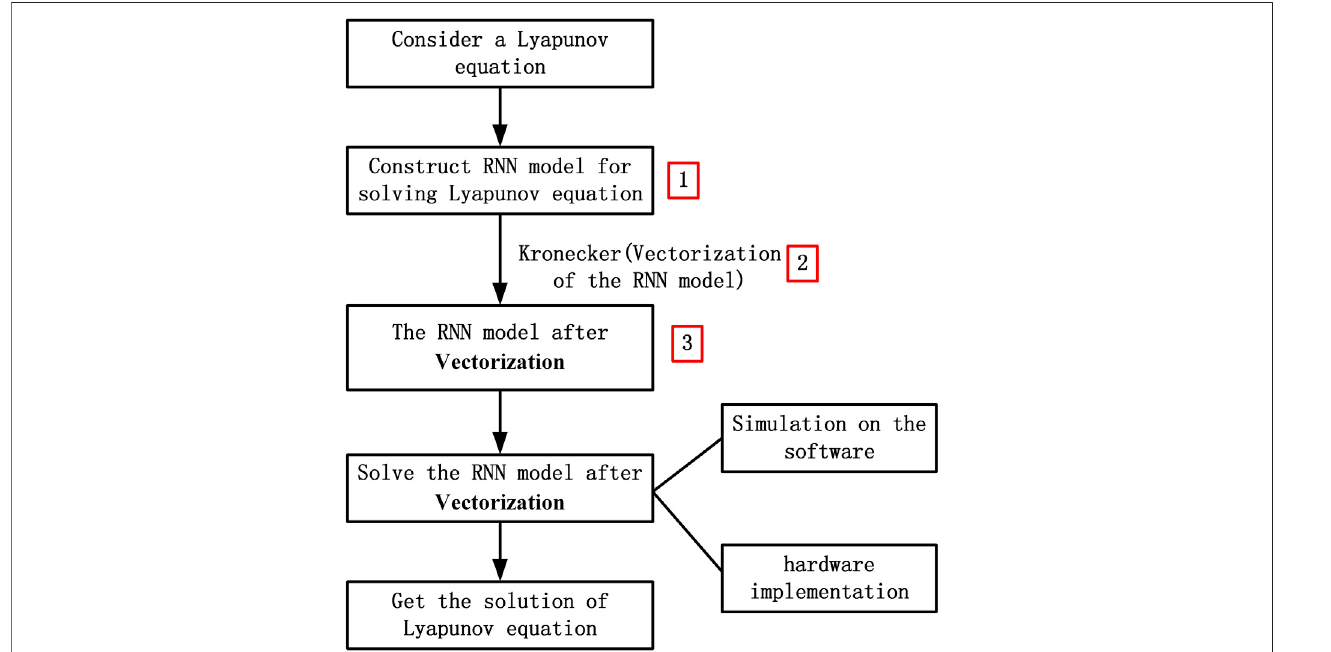
FIGURE 1 | Logical graph of using a RNN model for solving the Lyapunov equation.